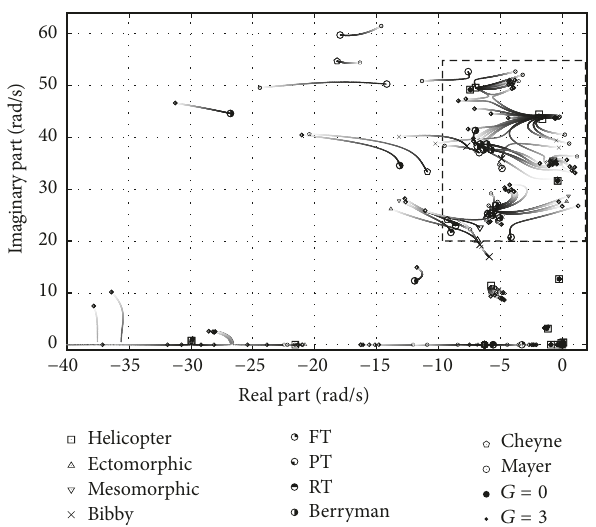
Figure 8: Areas delimited by root loci, for 𝐺 = 1 (violet), 2 (green), and 3